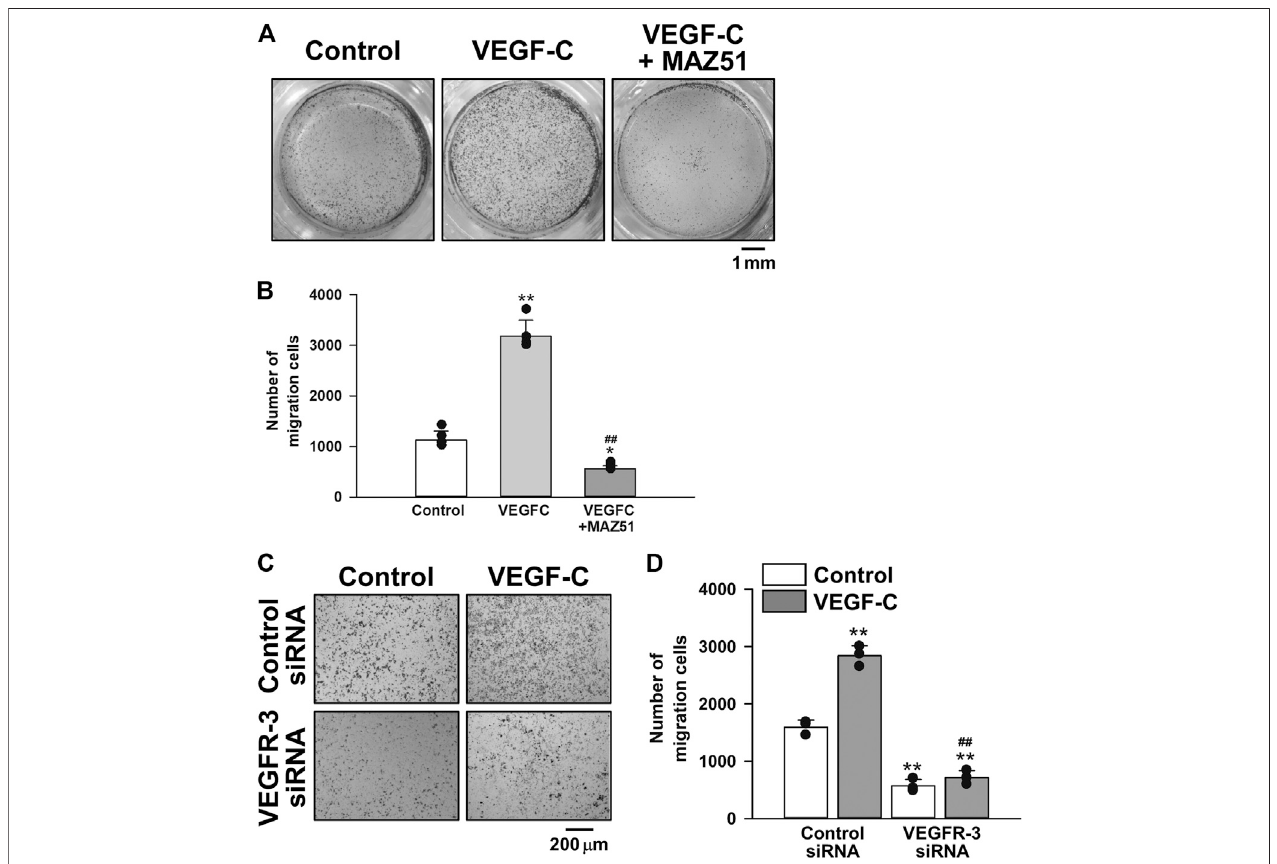
FIGURE 8 | Inhibitory effects of MAZ51 and VEGFR-3 siRNA on the migration of human prostate cancer PC-3 cells. The effects of VEGF-C on the migration of human prostate cancer PC-3 cells in the absence and presence of MAZ51 or VEGFR-3 siRNA were examined using the Transwell kit. (A) Representative images in the absence and presence of 50 ng/ml VEGF-C and 3 μ M MAZ51 for 18 h in PC-3 cells. (B) The effects of VEGF-C and MAZ51 on the migration of PC-3 cells ( n (cid:1) 4). (C) Representative images in the absence and presence ofVEGF-C for18 hin PC-3 cells treated with 50 nM VEGFR-3 siRNA for 48 h. (D) The effects of VEGF-C and VEGFR-3 siRNA on the migration of PC-3 cells ( n (cid:1) 3). Data are presented as means ± S.D. * p < 0.05, ** p < 0.01 vs. control or control siRNA/control; ## p < 0.01 vs. VEGF-C alone or control siRNA/VEGF-C (Scheffé ’ s test following ANOVA).